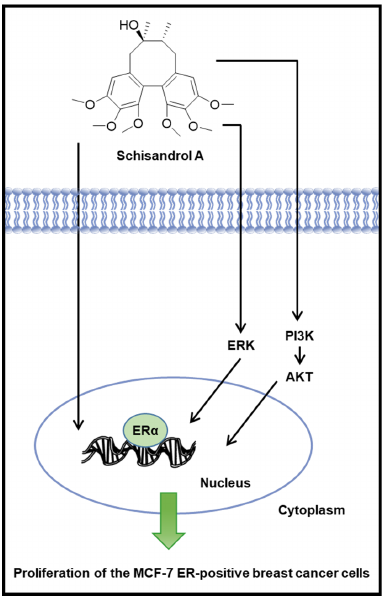
Figure 5. Schematic illustration of the underlying mechanism of the estrogenic activity of schisandrol A via estrogen receptor α (ER α )-dependent signaling pathways in MCF-7 estrogen receptor-positive breast cancer cells.